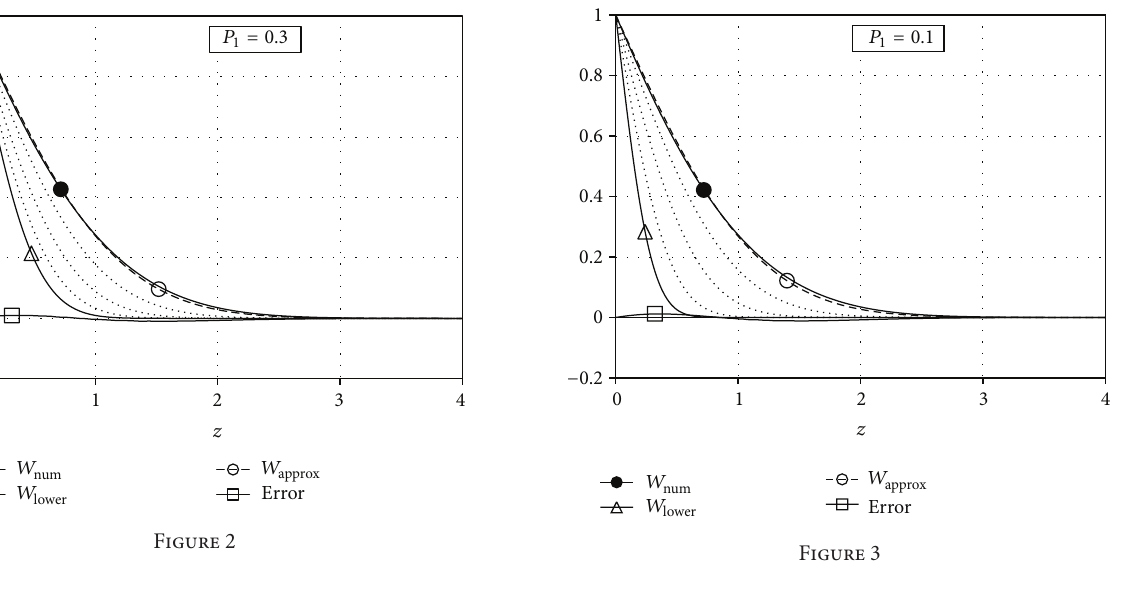
Using the similarity variables, the approximate solution of IBVP (6)-(7) for 𝑝 1 = 0.1 is found